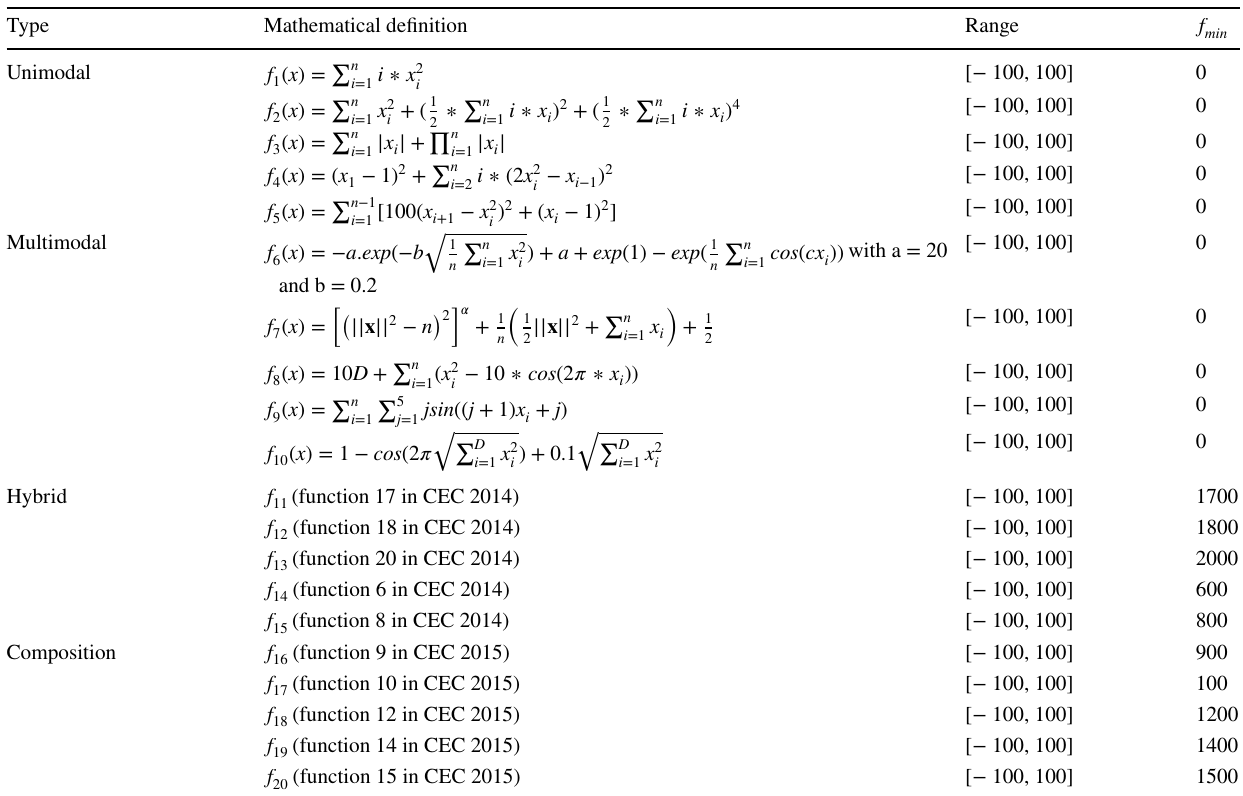
Table 1 Description of benchmark functions